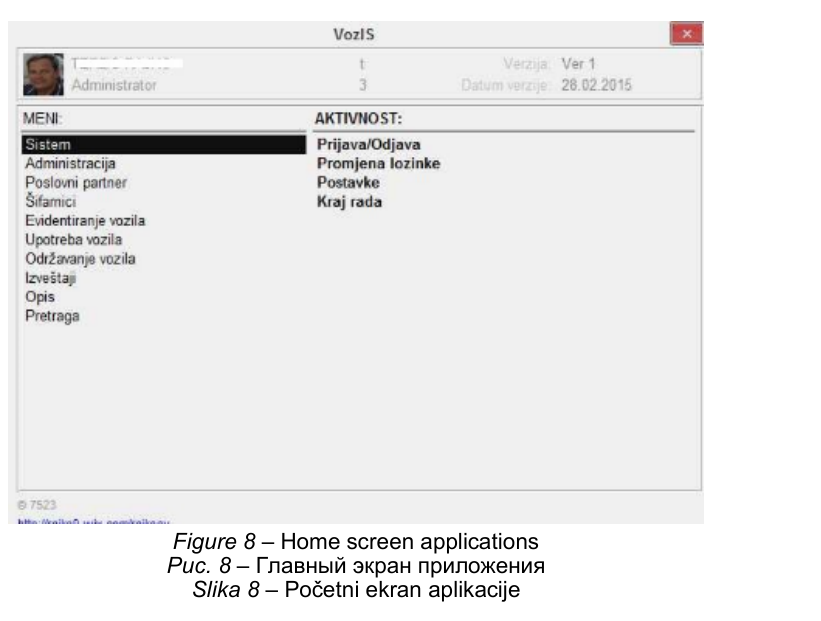
Figure 8 – Home screen applications Рис . 8 – Главный экран приложения